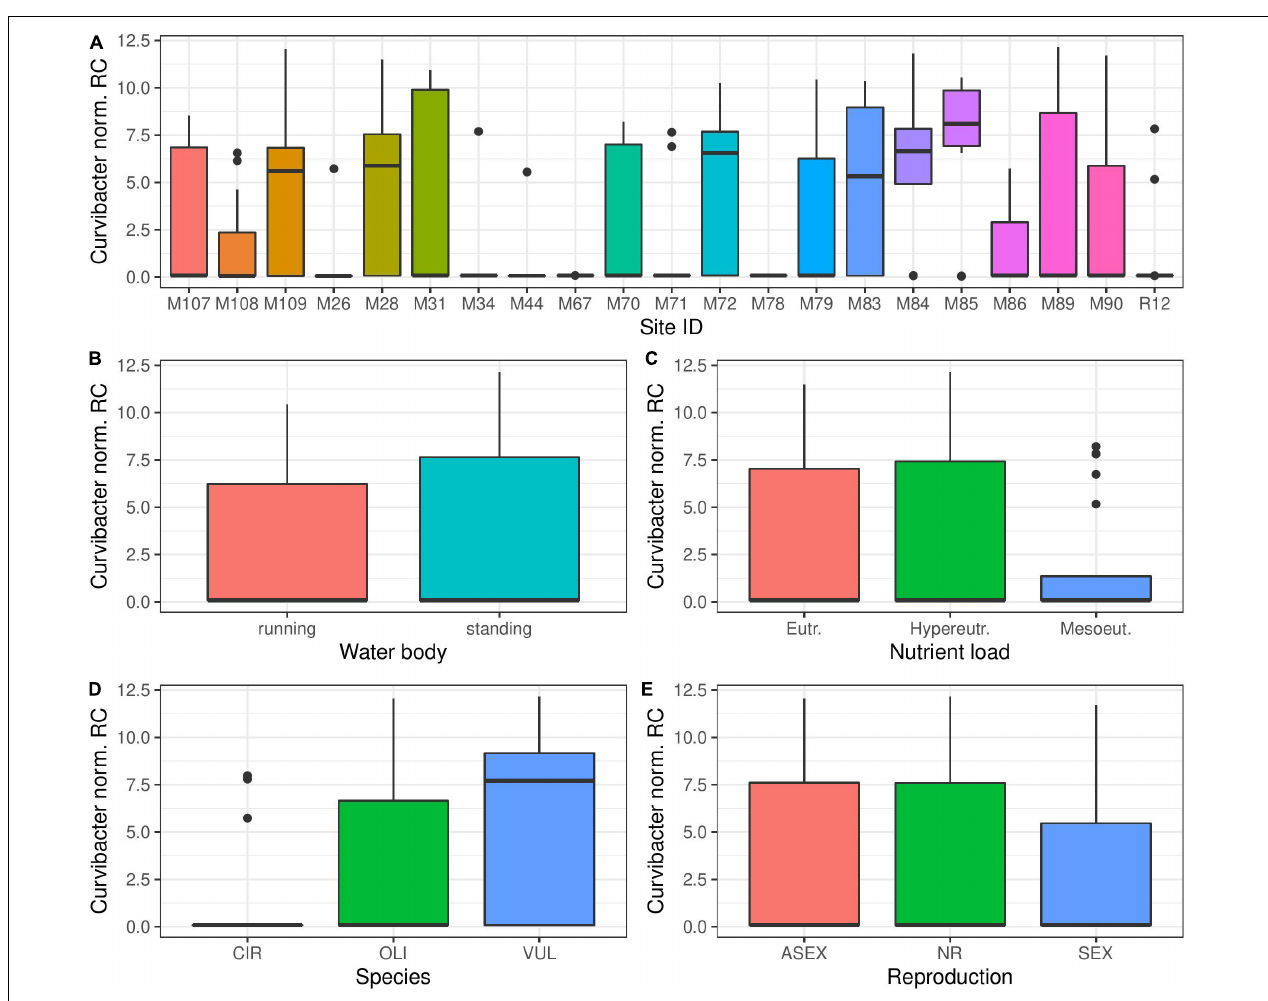
FIGURE 7 | Curvibacter , the main colonizer in laboratory strains of Hydra is consistently found in wild Hydra samples. The presence of Curvibacter species is dependent on the environmental conditions of different sampling sites (A) (Kruskal–Wallis, p < 0.001). However, nutrient load of the water (B) and type of water body (C) have no significant effect on the amount of colonizing Curvibacter (Kruskal–Wallis, p > 0.05, respectively). H. vulgaris polyps show a higher prevalence of Curvibacter colonization (D) (Kruskal–Wallis, p < 0.001). The mode of reproduction seems to have a small effect on the amount of Curvibacter colonization (E) (Kruskal–Wallis, p < 0.002). CIR, H. circumcincta ; OLI, H. oligactis ; VUL, H. vulgaris ; ASEX, asexual reproduction; NR, non-reproductive; SEX, sexual